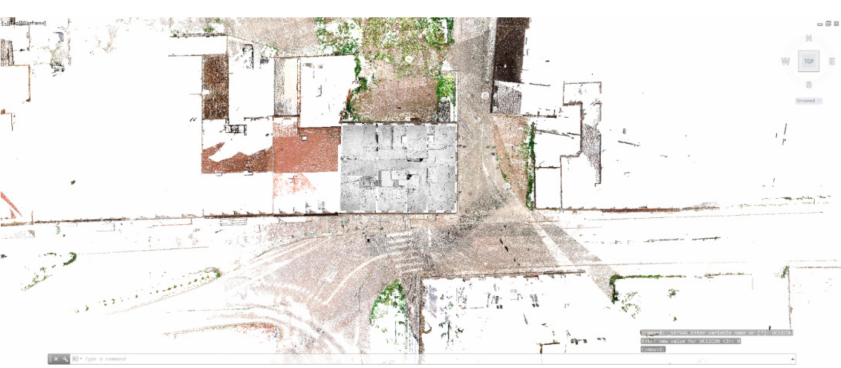
Figure 9. Outside view of the building made using TLS in Autocad 2015—aerial